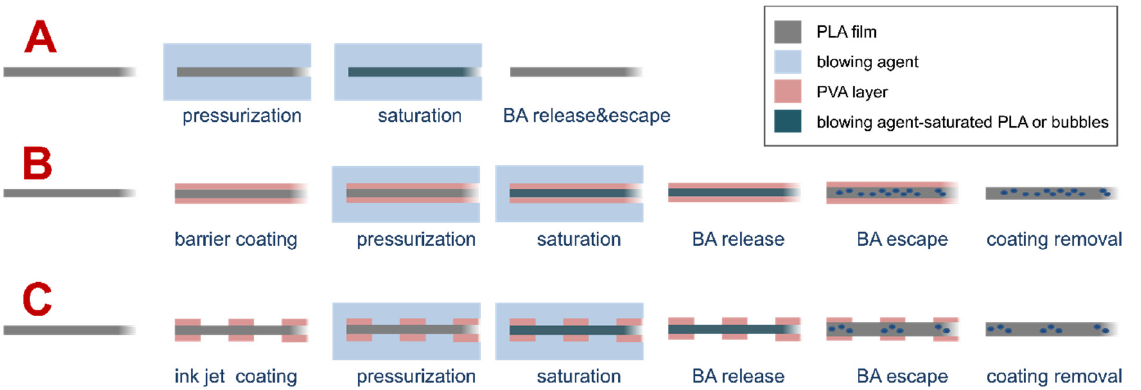
Figure 1. Scheme of the adopted method, to produce localized porosity by inkjet and gas foaming. Case ( A ), absence of a barrier layer; case ( B ), presence of a continuous barrier layer; case ( C ), presence of a patterned barrier layer. BA is for blowing agent.